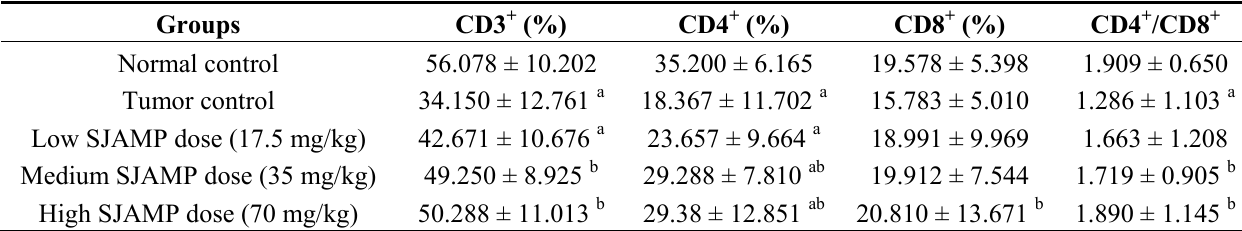
Table 8. Effect of SJAMP on peripheral blood T-lymphocyte subsets in rats with DEN-induced HCC ( x ±